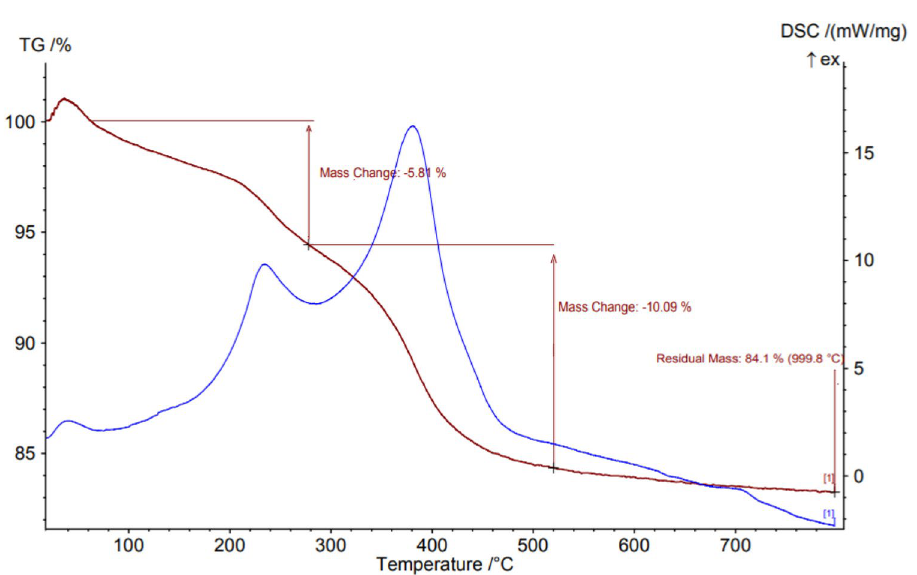
Figure 7. TGA curve of Fe 3 O 4 -PTMS-NAS@Cu MNPs.